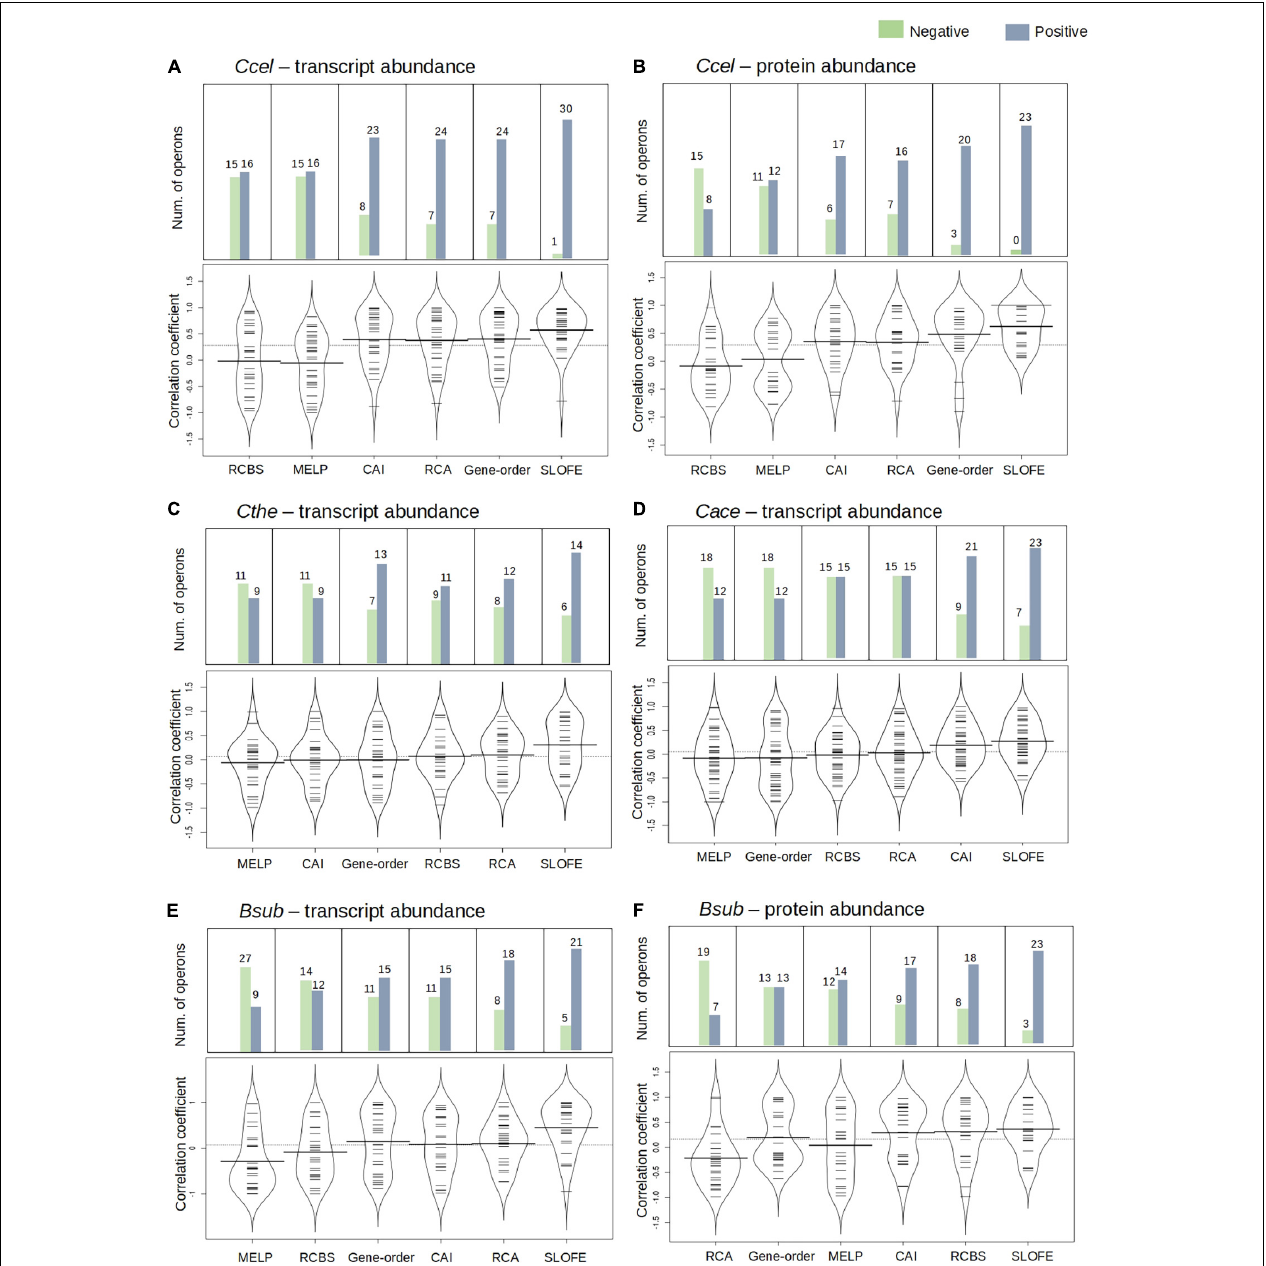
FIGURE 5 | Performance of stem–loop free energy (SLOFE) as compared with the five existing programs that predict transcript- and protein-level stoichiometry in selective RNA processing and stabilization (SRPS) operons in four genomes. Codon adaptation index (CAI), relative codon usage bias (RCBS), relative codon adaptation (RCA), measure independent of length and composition (MILC)-based expression level predictor (MELP), and gene order predict the ratio based on the codon usage bias of the gene sequences. Comparison of the methods, for the transcript and protein abundance prediction in Ccel (A,B) , Cthe (C) , Cace (D) , and Bsub (E,F) , is shown using the bean plot, where the small dashes are the correlation coefficient values and the bold bar represents the median of the values. The dashed line across the bean plot represents the average of all the values. For each method, a bar plot shows the number of SRPS operons carrying ratios that are positively ( blue ) or negatively ( green ) correlated with the experimentally determined ratios